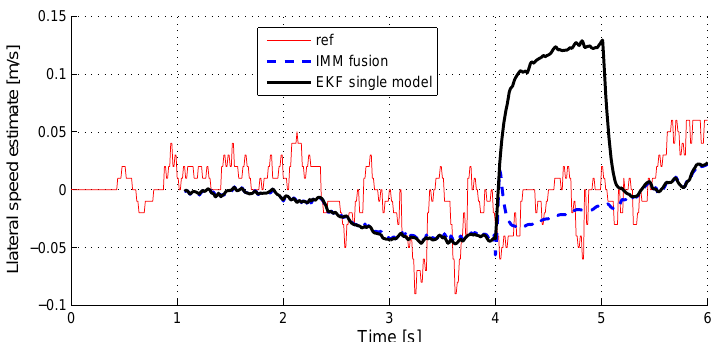
Figure 10. Lateral speed estimate with Y-acceleration sensor